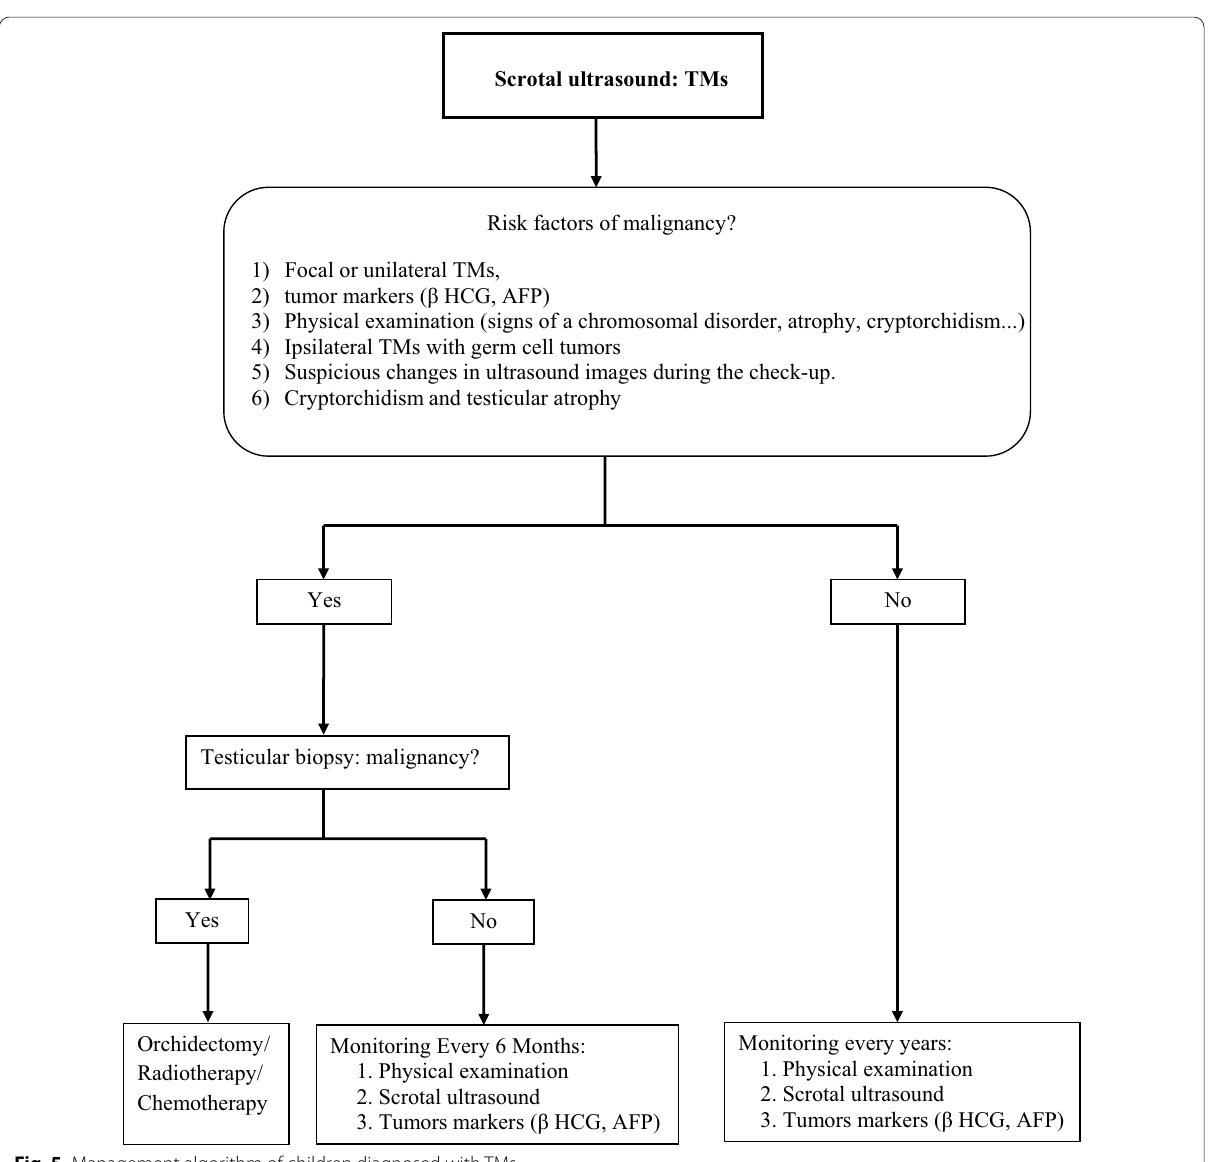
Fig. 5 Management algorithm of children diagnosed with